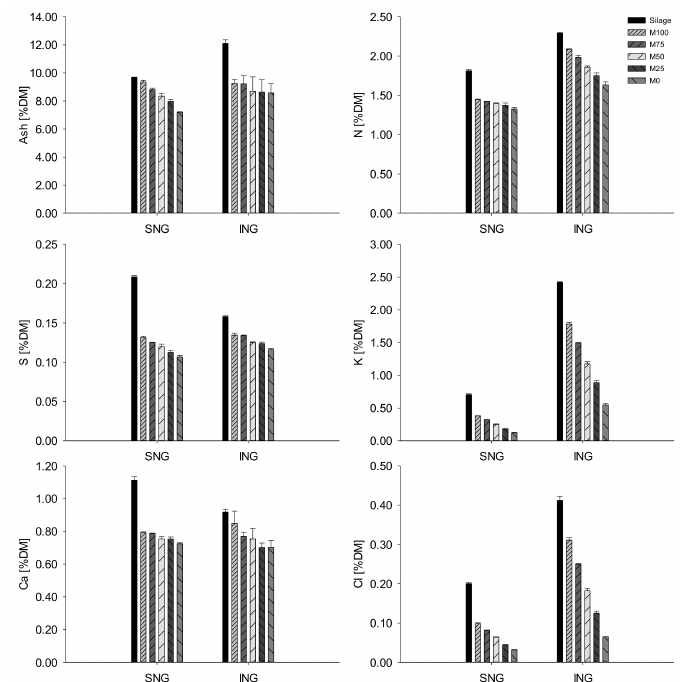
Figure 3. Experiment 3: Mean concentrations of ash, N, S, K, Ca and Cl in silage and press cakes obtained from dewatering after leaching with liquids with varying shares of recycled press liquid (M100/75/50/25/0 = 100%/75%/50%/25%/0% press liquid). Elemental concentrations are shown for biomass from semi-natural (SNG) and intensive (ING) grassland biomass. Error bars depict the standard errors of the means. Table 4. Experiment 3: Statistical results for ash, N, S, K, Ca and Cl concentrations in press cakes from semi-natural and intensive grassland biomass, as obtained after leaching with liquids with